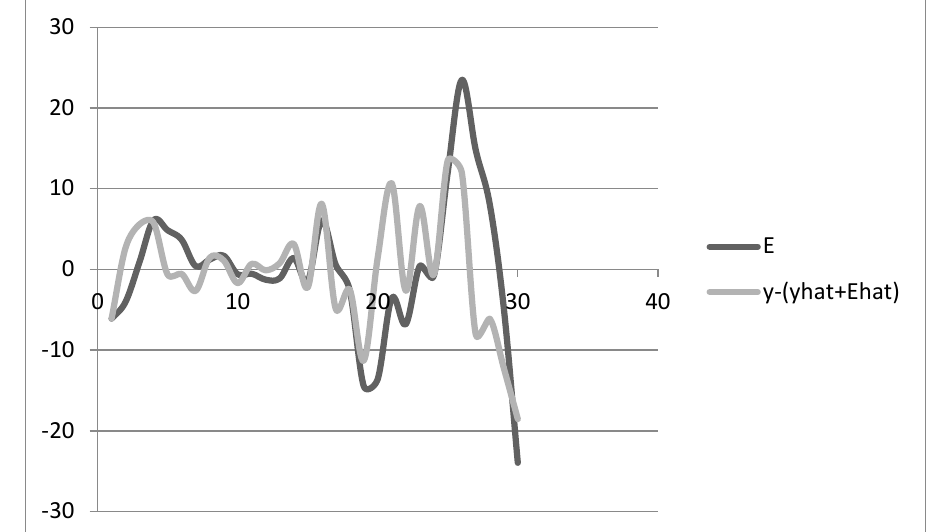
Figure 3. Comparing the residuals of the polynomial model E with the residuals of the compound model y-(yhat + Ehat). Source: Authors’ calculations.